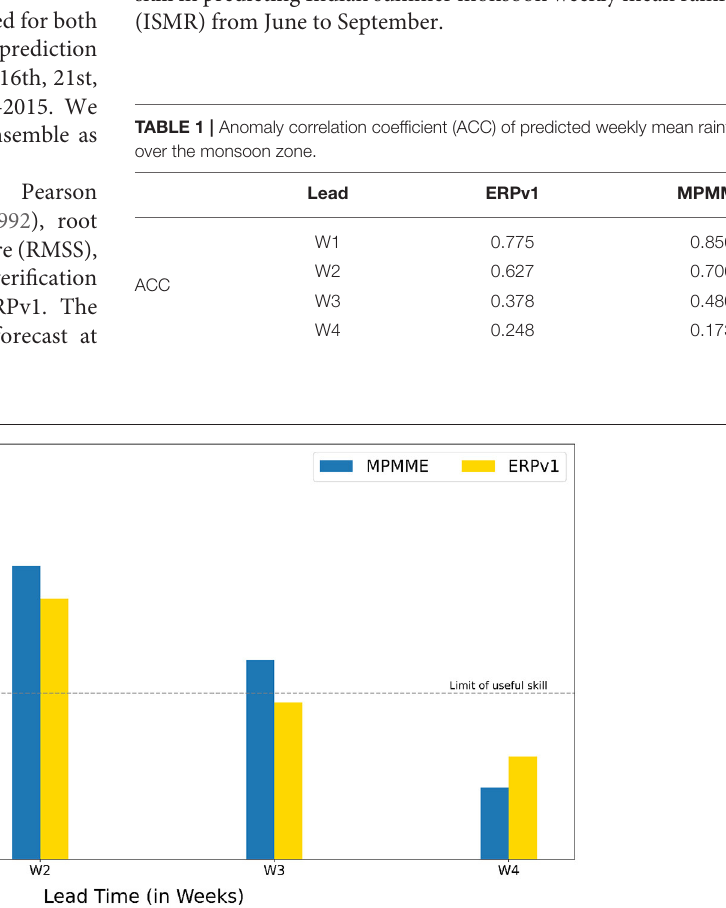
Frontiers in Climate |